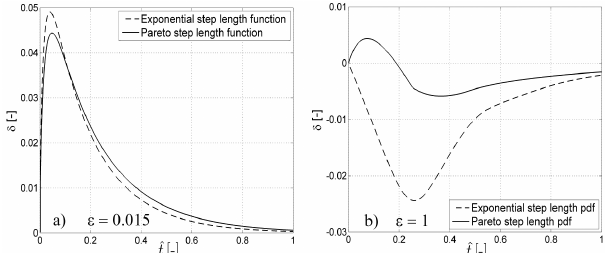
Figure 9. Variation in time of the concavity parameter δ for the case of the thin-tailed exponential distribution for step length, and the case of heavy-tailed Pareto distribution for step length. The pa- rameter ε = ¯ r / L d takes the value 0.015 in (a) and 1.0 in (b)